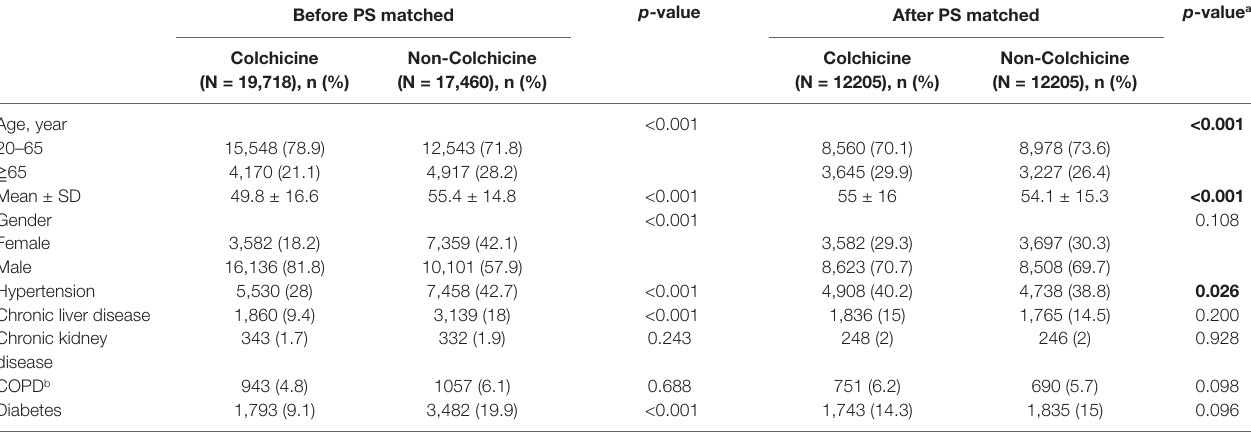
TABLE 1 | Demographic characteristics of gout patients treated with and without